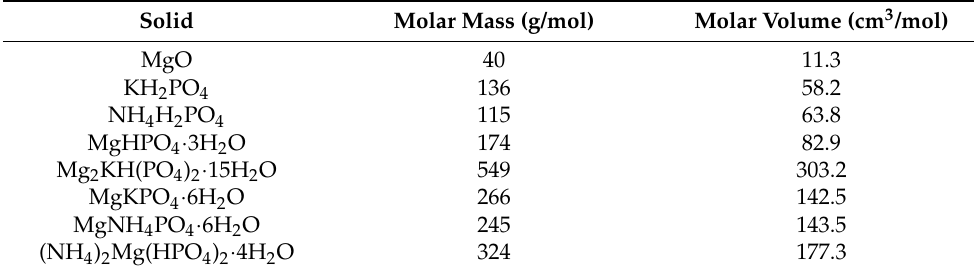
Table 3. Molar density and molar mass of reactants and hydration